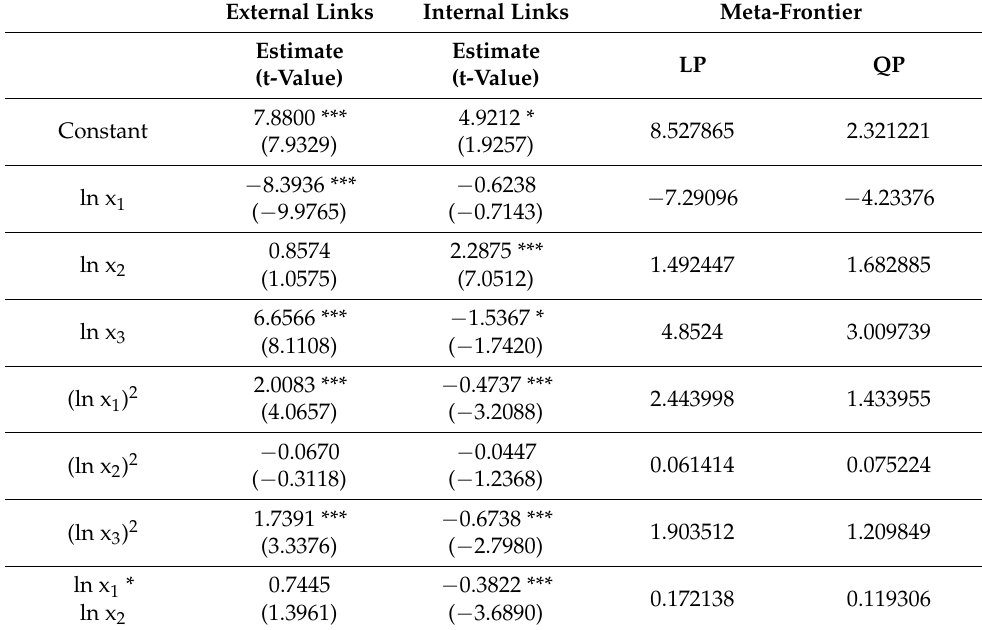
Table 2. Estimation results of group and meta-frontier production